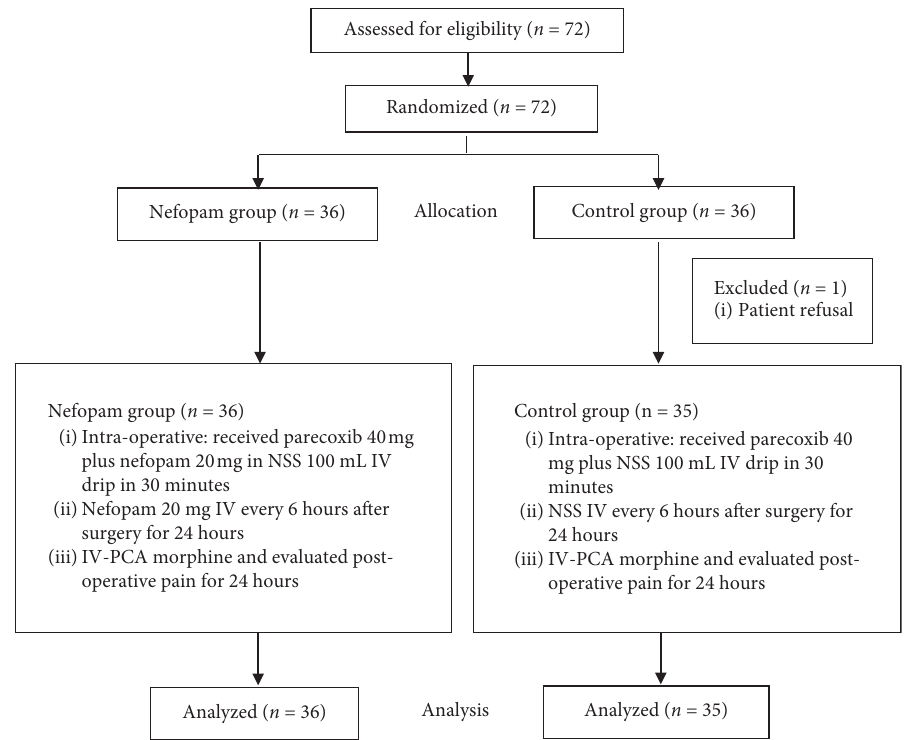
Figure 1: A study flow chart.